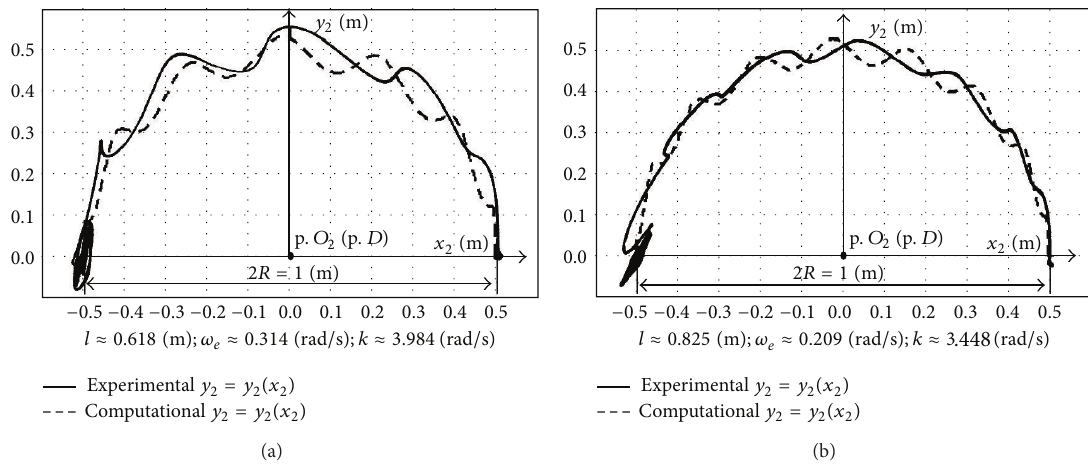
Figure 5: The comparison of the small swaying angle 𝛼 1 theoretical (- - -, 𝑦 2 = 𝑦 2 (𝑥 2 ) ) and experimental (—, 𝑦 2 = 𝑦 2 (𝑥 2 ) ) load absolute trajectories in the inertial reference frame E for fixed cable length 𝑙 = 0.618 m (a) and fixed cable length 𝑙 = 0.825 m